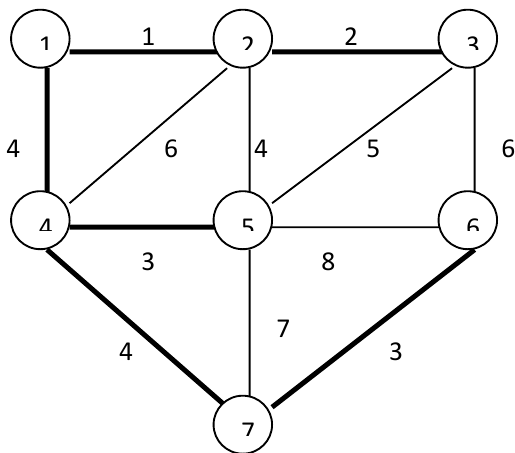
Figure 1. A minimum spanning tree graph with thick edges.